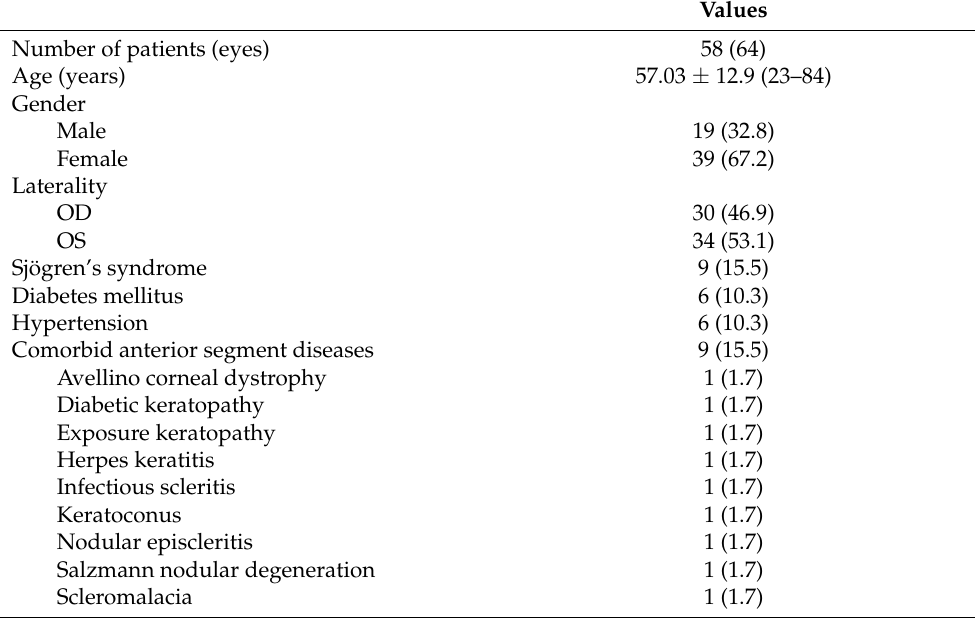
Table 1. Demographic features of patients.